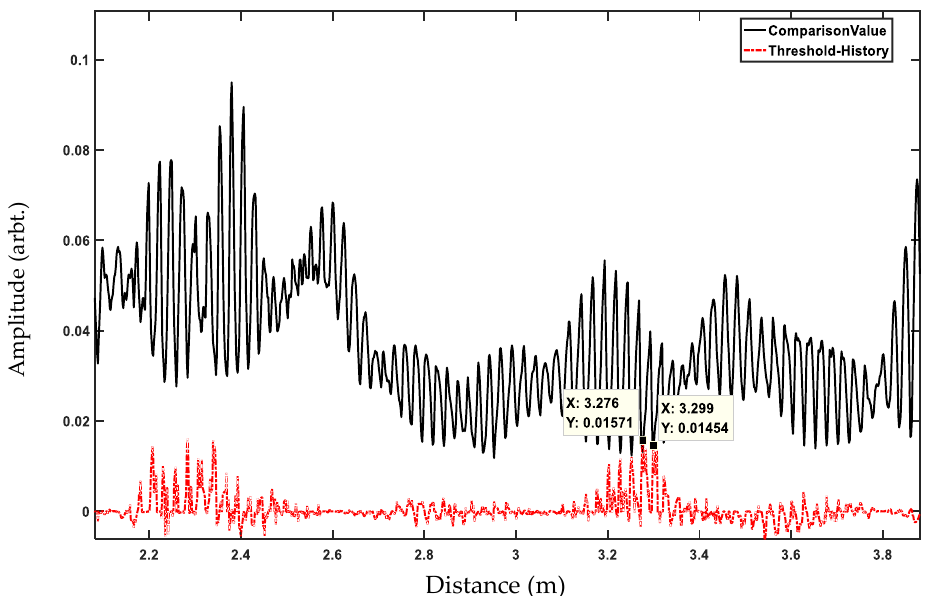
Figure 8. Calculated percentage of sensors with same phase, where the offset (mean values) are removed (orange); the black signal is showing the filtered version for better illustration.